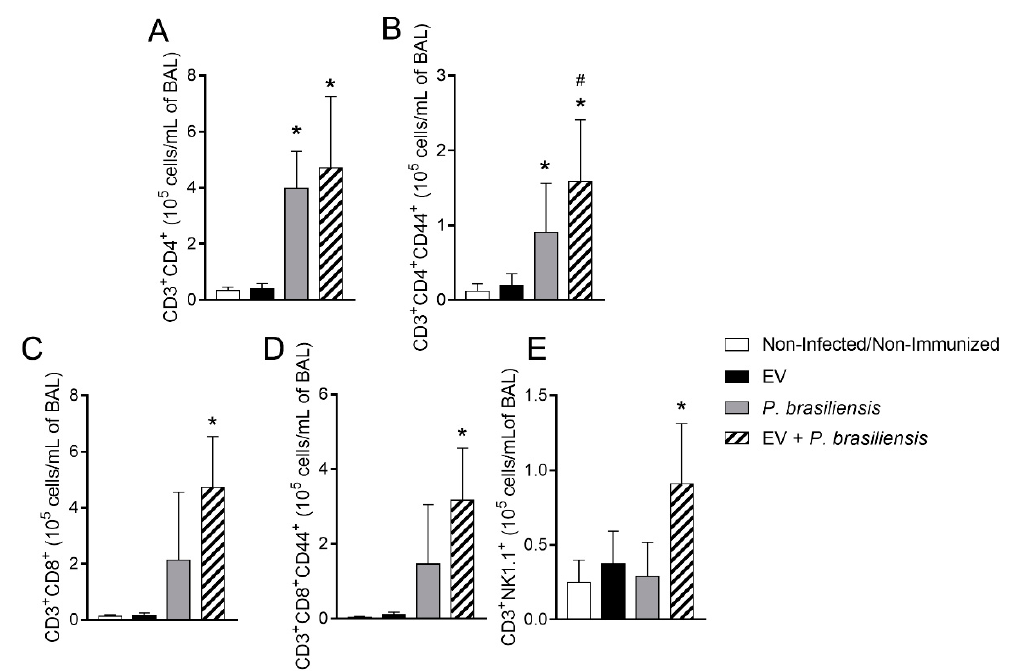
Figure 4. Memory CD4 + and CD8 + T-cells and NKT cells recalled by P. brasiliensis infection at day 7 post-infection. CD3 + CD4 + T lymphocytes ( A ). CD3 + CD4 + CD44 + T lymphocytes ( B ). CD3 + CD8 + T lymphocytes ( C ). CD3 + CD8 + CD44 + T lymphocytes ( D ). CD3 + NK 1.1 + cells ( E ). * p ≤ 0.05 compared to non-infected/non-immunized and EV groups. # p ≤ 0.05 compared to P. brasiliensis group. Non-infected/non-immunized (control). Immunization for 42 days with two doses of 1000 ng of EV protein with adjuvant (boost dose, without adjuvant, given 14 days after the first dose). Mice were infected on day 42 post-immunization. BAL was collected 7 days post-infection with P. brasiliensis for flow cytometry analysis. n = 6 animals per group. Data represents one experiment.